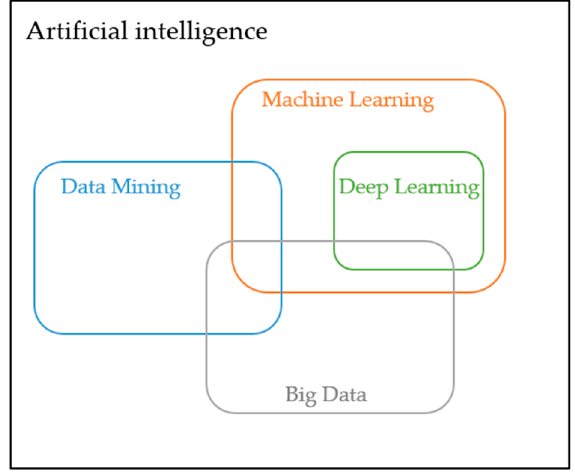
Figure 1. AI techniques interrelation.